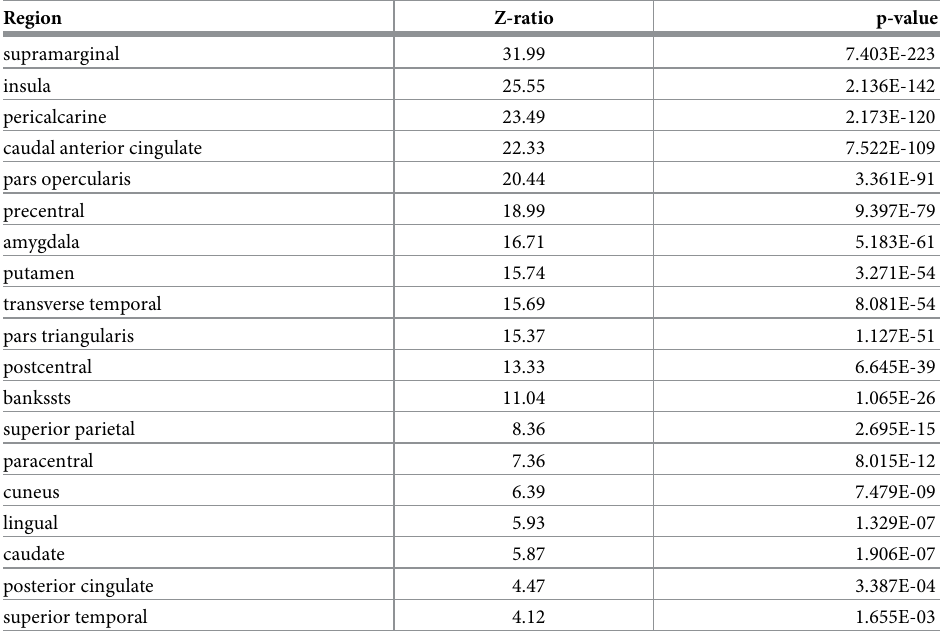
Table 4. Cortical and subcortical areas showing reliable co-activity with IC2 (correlated with ventral attention net- work) relative to the mean co-activity value of all other areas. p-values corrected for multiple comparisons using Bonferroni correction.